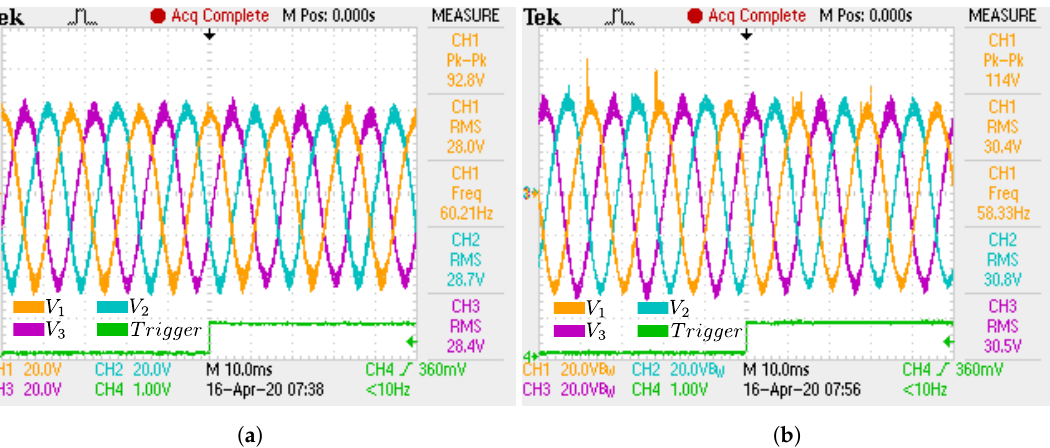
Figure 32. Experimental load phase voltages for RL transition load case: ( a ) First transition; ( b ) Second transition.